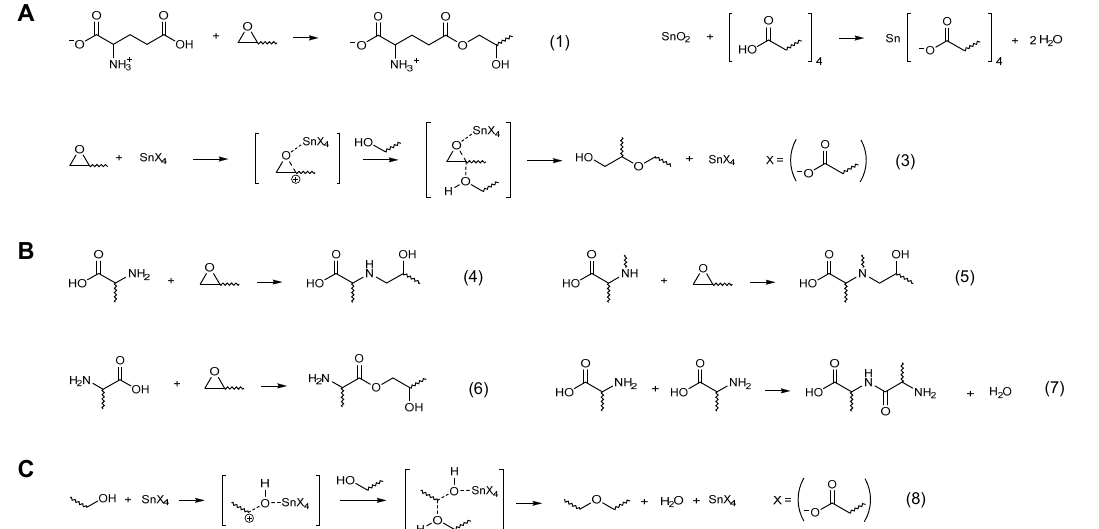
Figure 4. Proposed mechanism of thermochemical reaction between DGEBF, Glu, and SAC305 . ( A ) Reaction of epoxy and γ -carboxylic acid of Glu with SAC305. Esterification of epoxy with γ -carboxylic acid (1). Dissolution of tin oxide by γ -carboxylic acid (2). Etherification between epoxy and hydroxyl groups with the catalytic effect of tin carboxylate salt (3). ( B ) Reaction of epoxy and activated amino acid group. α -Primary amine-epoxy addition (4). α -Secondary amine-epoxy addition (5). Esterification of epoxy with α -carboxylic acid (6). Peptide bond formation between two amino acid molecules (7). ( C ) Etherification between alcohols with the catalytic effect of a tin carboxylate salt (8).